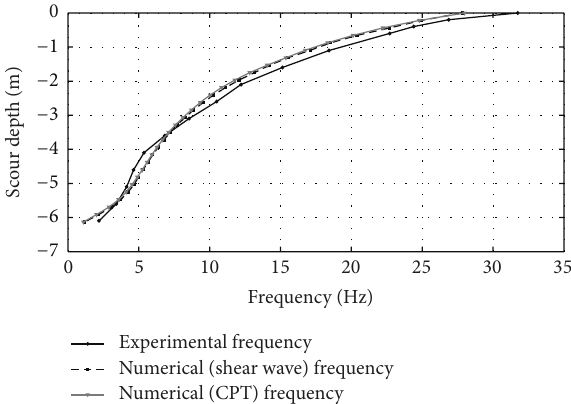
Figure 1: Frequency change with scour for experimental and numerical models